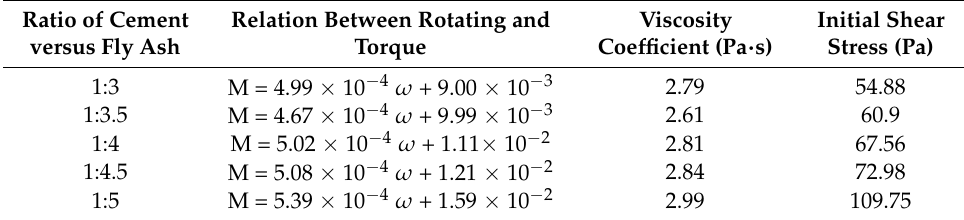
Table 11. Relation between rotating speed and torque at different ratios of cement to fly ash and the resulting rheological parameters of the slurry.